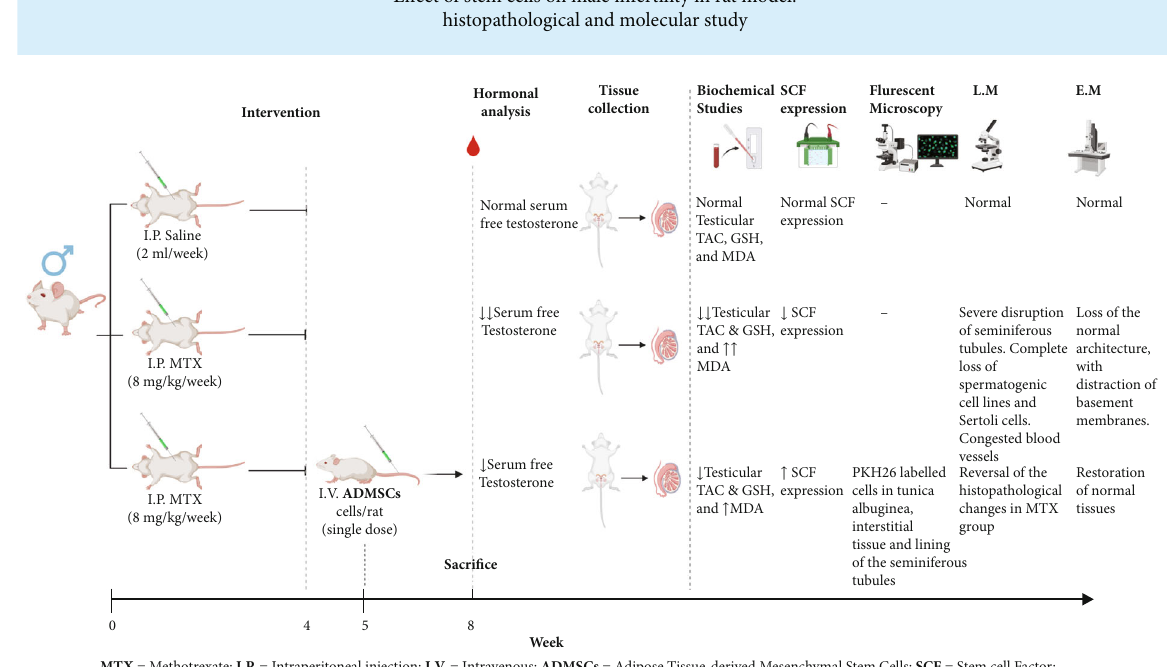
Figure 12: Summary of the used experimental methods and